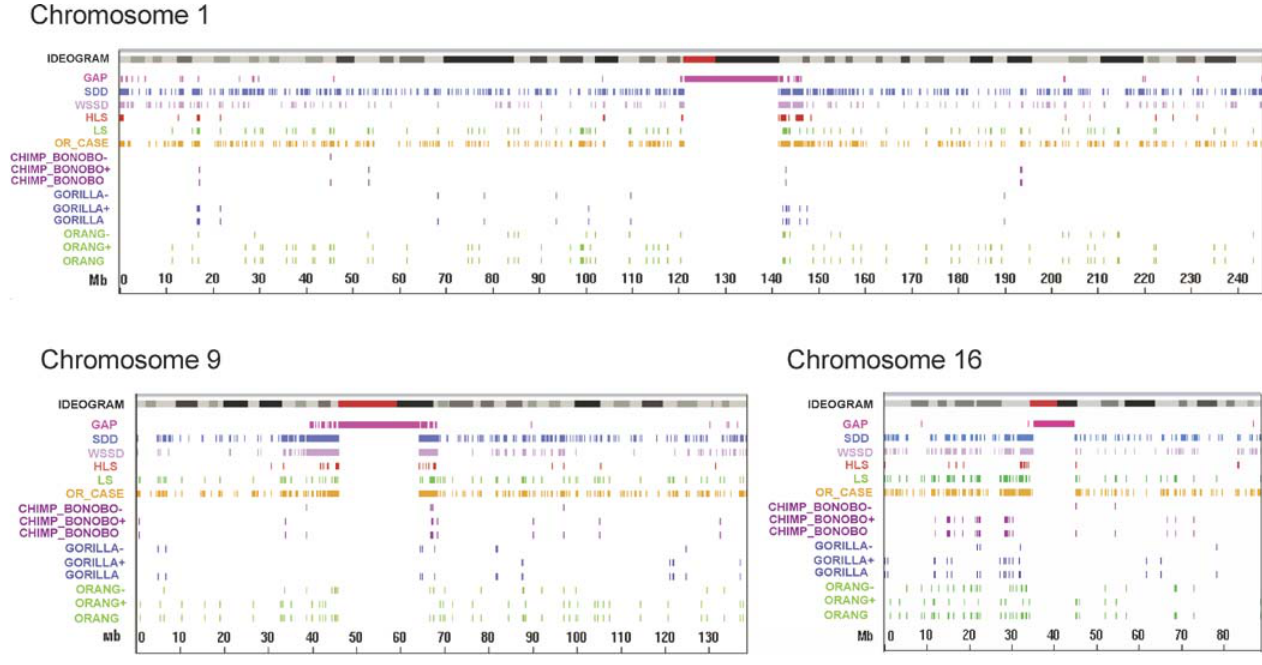
Figure 2. Clustering of Lineage-Specific Gene Copy Number Variations, Segmental Duplications, and Sequence Gaps HLS, LS, and OR_CASE BLAT analysis results were plotted along each chromosome (Build 35) using a modified version of the Genotator annotation browser [77]. HLS and LS refers to those genes identified by Fortna et al. [34] that showed aCGH-predicted gene copy number changes specific for the HLS and for one or more great ape lineages (LS), respectively. OR_CASE refers to those genes for which the aCGH-predicted copy number in human is different from one or more great ape lineages. All available ESTs were downloaded from GenBank for each IMAGE clone in the HLS, LS, and OR_CASE datasets. These ESTs were then aligned to the human genome (Build 35) using a locally installed version of BLAT. All BLAT hits with a score greater than 200 and a percent identity greater than 90% were kept for further analysis. Furthermore, the BLAT hits were parsed down such that only one hit per gene was reported to avoid multiple hits due to isoforms. The LS data set was split into subgroups to indicate orangutan, gorilla, and bonobo plus chimpanzee copy number differences. For these LS subgroups, all differences (gains and losses) are plotted as well as the copy number gains (indicated by a ‘‘ þ ’’ ) and copy number losses (indicated by a ‘‘ (cid:2) ’’ ). Furthermore, the WSSD and SDD annotations [23] were downloaded from UCSC (http:// genome.ucsc.edu/) and plotted to illustrate the locations of recent ( , 40 Mya) segmental duplications in the human genome. Also included is the annotation of the known sequence gaps and an ideogram showing the location of the centromere (red) and the Giemsa staining patterns. Data for Chromosomes 1, 9, and 16 are shown. Data for all chromosomes can be found in Supplementary Figure